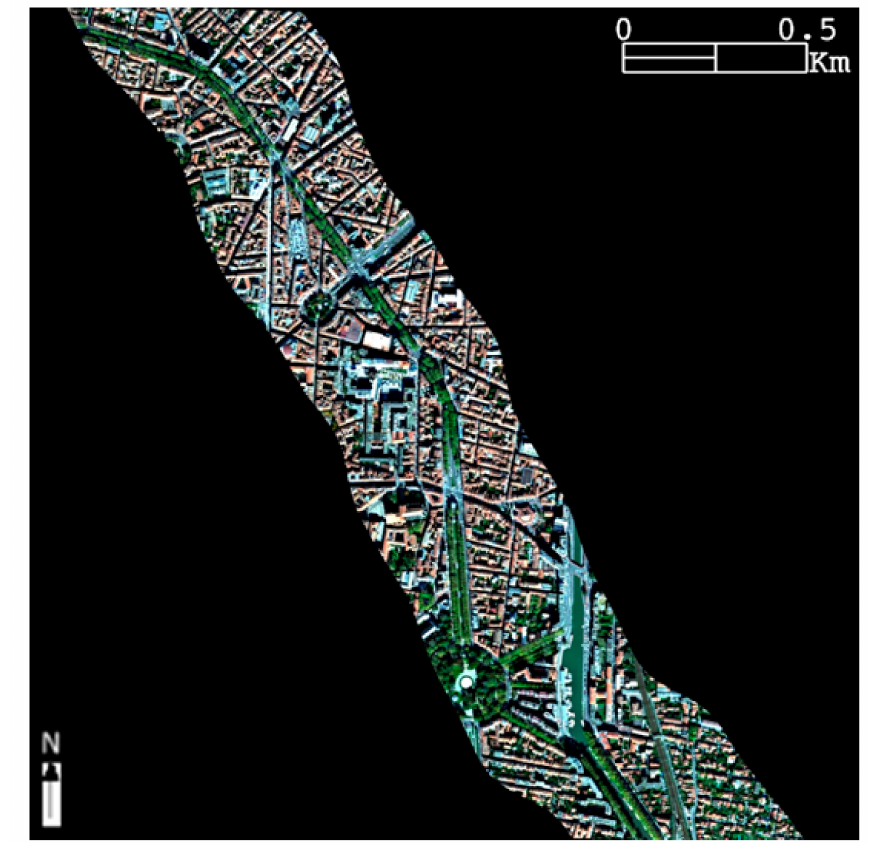
Figure 4. True color image composite of the considered full hyperspectral